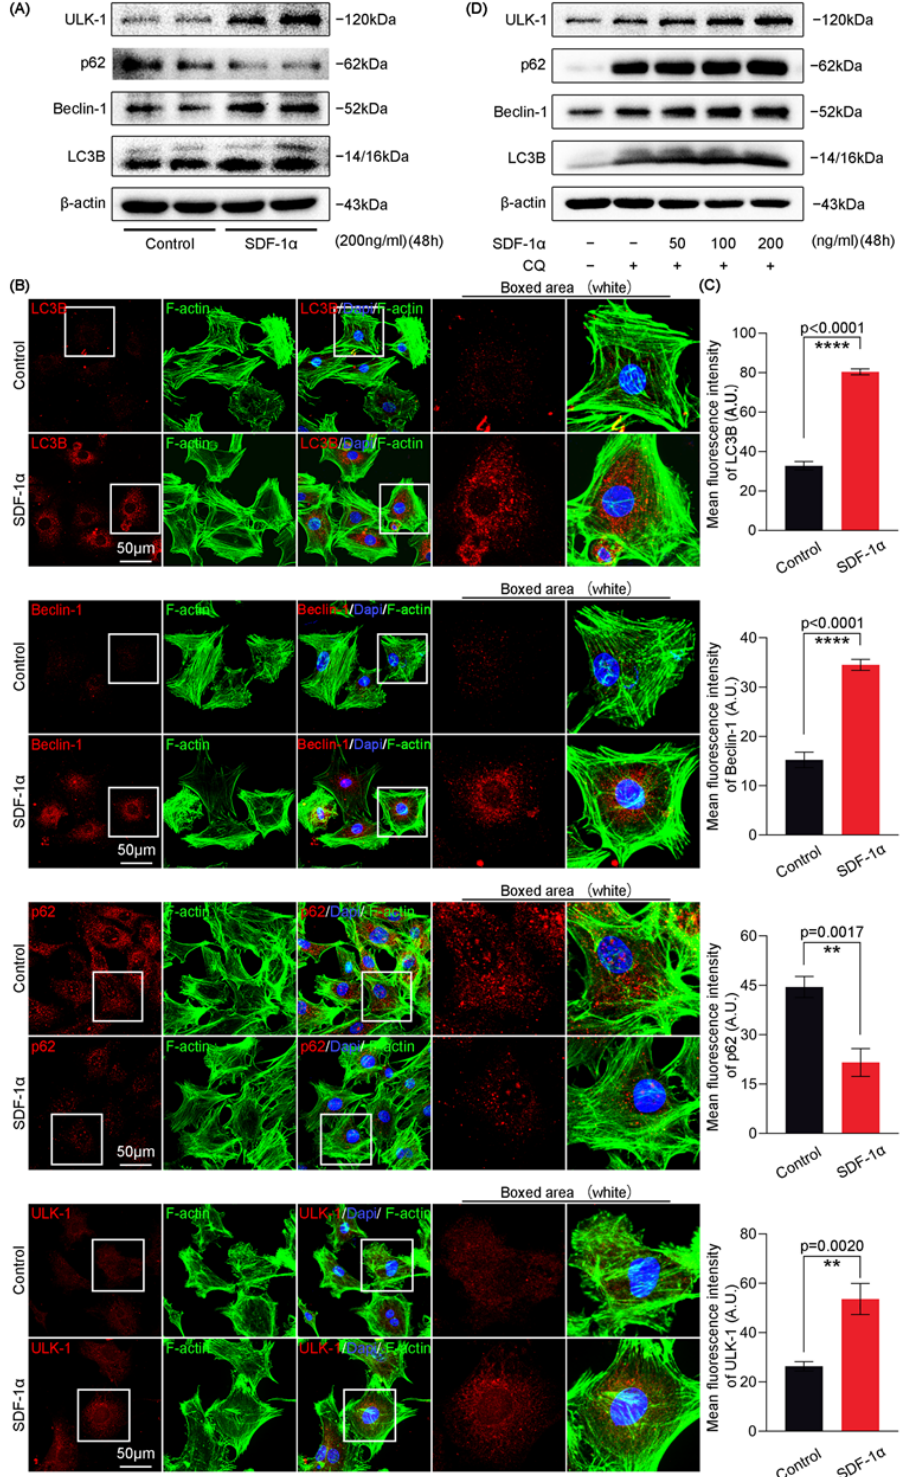
Figure 2. SDF-1 α increases the expression of autophagy-related proteins in chondrocytes. ( A ) Representative western blots showing that the expression of ULK-1, Beclin-1 and LC3B increased, and that the expression of p62 decreased after treatment with SDF-1 α (200 ng/mL) for 48 h. ( B ) Representative immunofluorescent images indicating the expression and distribution of ULK-1, p62, Beclin-1 and LC3B in chondrocytes induced by SDF-1 α (200 ng/mL) for 48 h. ( C ) Quantification of the mean fluorescence intensity of autophagy-related proteins in chondrocytes shown in ( B ). We